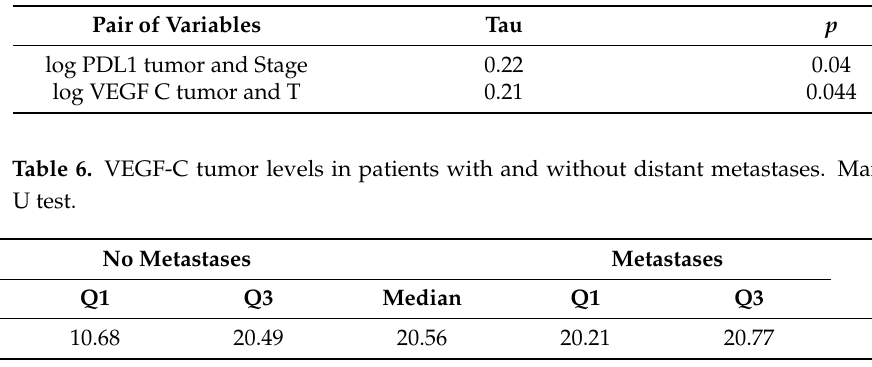
Table 5. Correlations between PD-L1, VEGF-C tumor levels, and clinical parameters of patients (Tau-Kendall’s tau rank correlation coefficient).